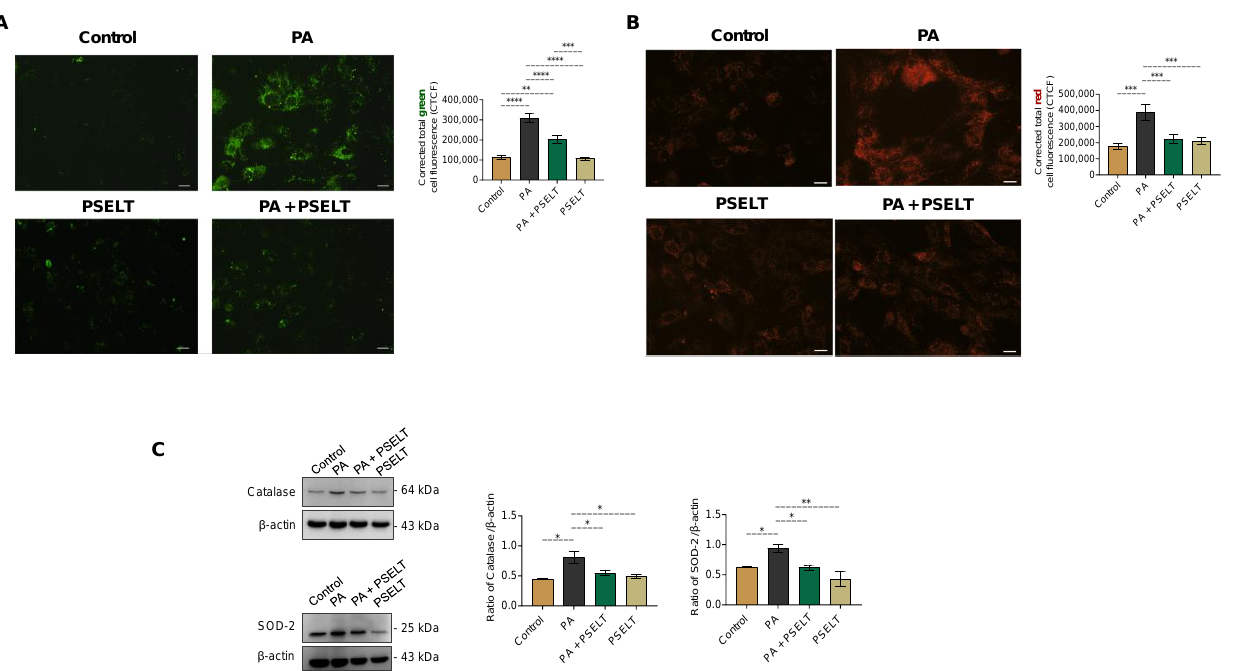
Figure 2. Effects of PSELT on PA-induced oxidative stress in H9c2 cardiomyocytes. ( A ) Representa- tive images of a fluorescent probe (CM-H 2 DCFDA) for ROS detection with relative fluorescence quantification. Data are expressed as the mean ± SEM ( n = 3 different experiments). Significant dif- ferences in corrected total cell fluorescence (CTCF) were detected by one-way ANOVA and New- man-Keuls multiple comparison test p < 0.01 (**); p < 0.001 (***); and p < 0.0001 (****). ( B ) Superoxide (O 2− ) levels assessed by the MitoSOX fluorescent probe and quantification of the fluorescence inten- sity in H9c2 cardiomyocytes treated with vehicle (Control), PA 100 µmol/L, PA + PSELT 5 nmol/L or PSELT for 24 h. Data are expressed as the mean ± SEM ( n = 3 different experiments). Significant differences in CTCF were detected by one-way ANOVA and Newman-Keuls multiple comparison test , p < 0.001 (***). Western blot analysis of ( C ) Catalase and SOD-2 in H9c2 cardiomyocytes treated with vehicle (Control), PA 100 µmol/L, PA + PSELT 5 nmol/L or PSELT for 24 h. Histograms repre- sent the ratio of the densitometric analysis of protein:loading control. Statistical differences were analyzed by Newman-Keuls multiple comparison test (one-way ANOVA) p < 0.05 (*); p < 0.01 (**).